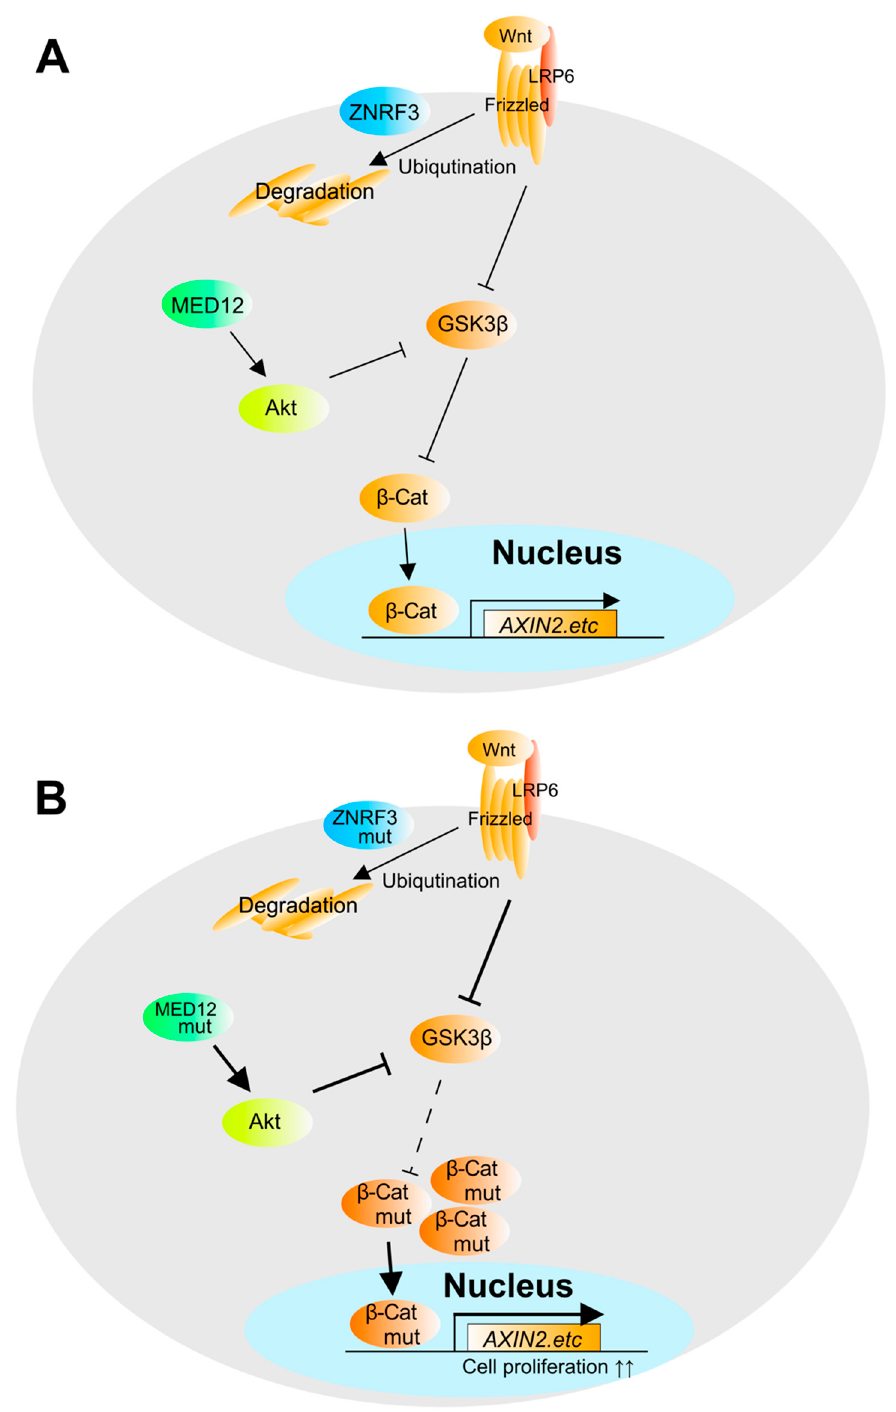
Figure 8. Genetic mutations in adrenocortical carcinoma. In adrenocortical carcinoma, mutations in the β -catenin system have been reported. ( A ) β -catenin pathway in non-ACC. ( B ) β -catenin pathway in ACC. AXIN2 is β -catenin regulator via GSK3B. ZNRF3 is a ubiquitin ligase that regulates the degradation of Frizzled and LRP6. Mutation of MED12 enhances the activation of Akt and further enhances the transcriptional activity of β